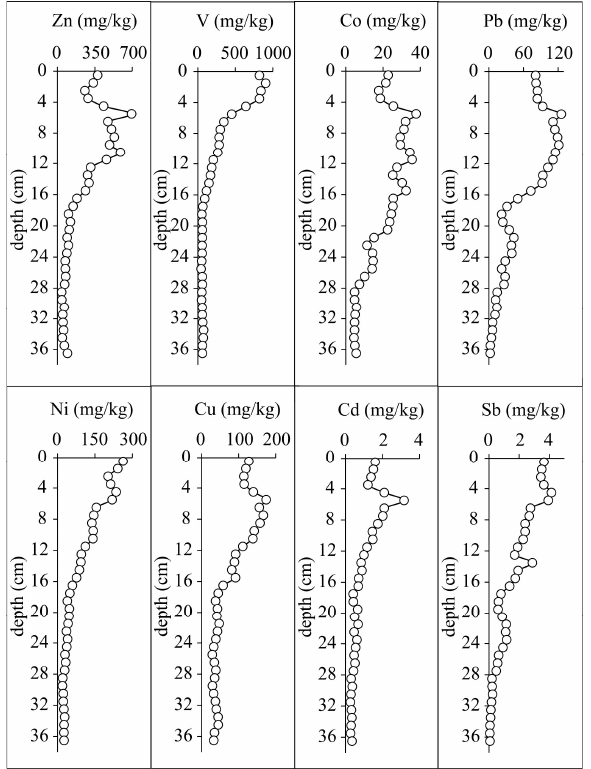
Figure 14. The vertical distribution of heavy metals in sediments of Lake Semenovskoe (Murmansk Region) [52].